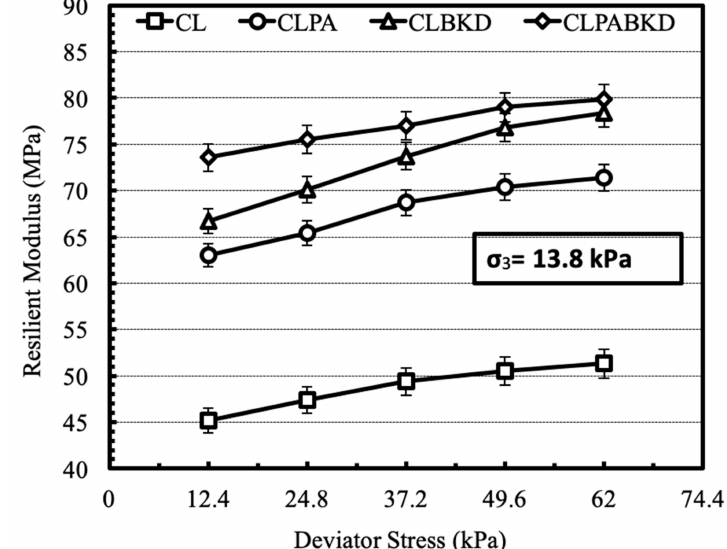
Figure 13. Variation in M R of optimum mixtures (unsoaked) with cyclic deviator stress at a confining pressure of 13.8 kPa.